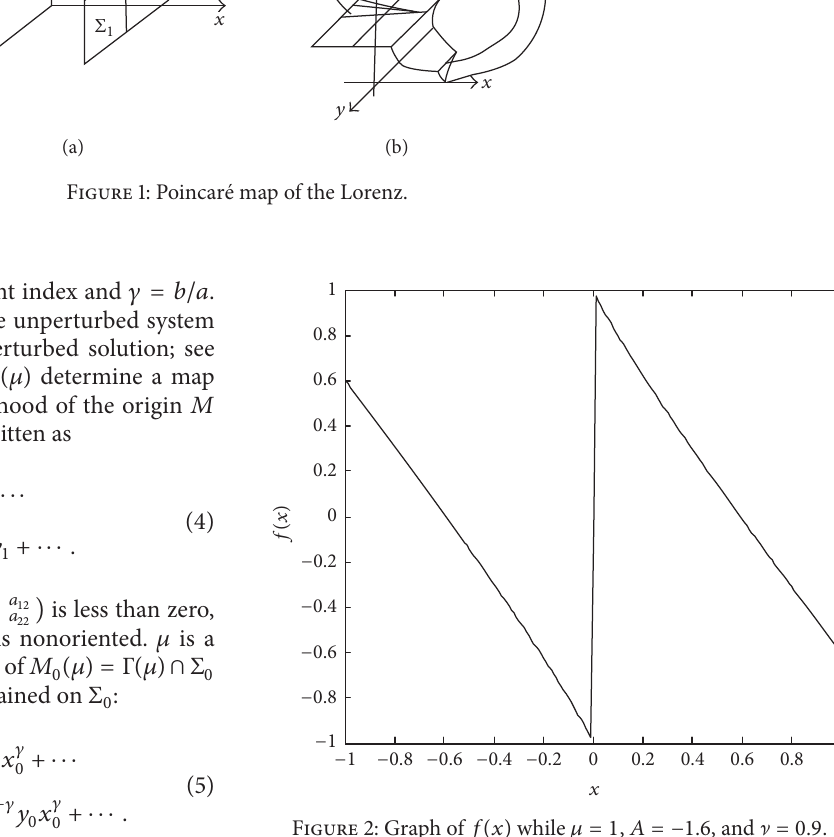
Figure 2: Graph of 𝑓(𝑥) while 𝜇 = 1 , 𝐴 = −1.6 , and ] = 0.9